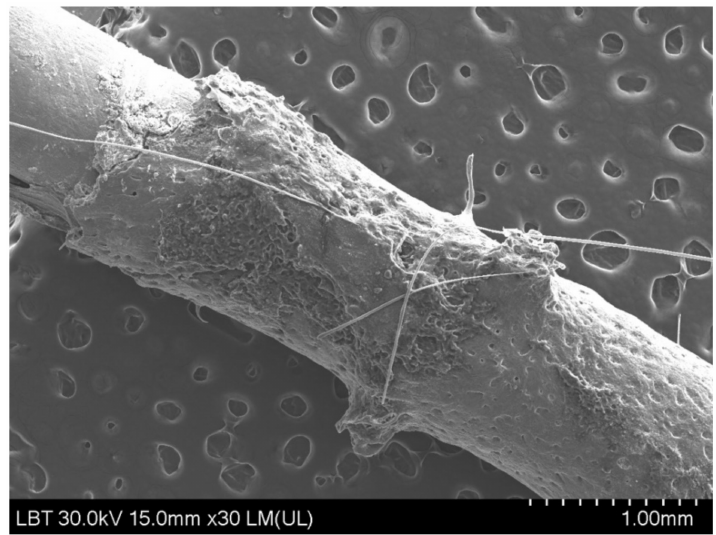
Figure 11. Scanning electron microscopy image of one case with an increased concentration on both calcium and